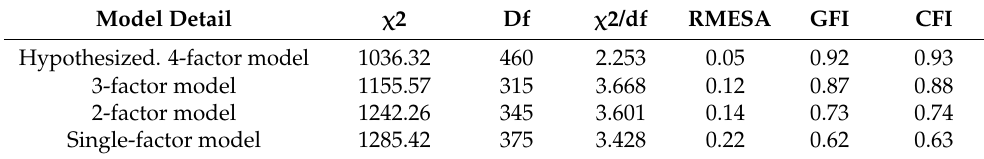
Table 2. CFA results.